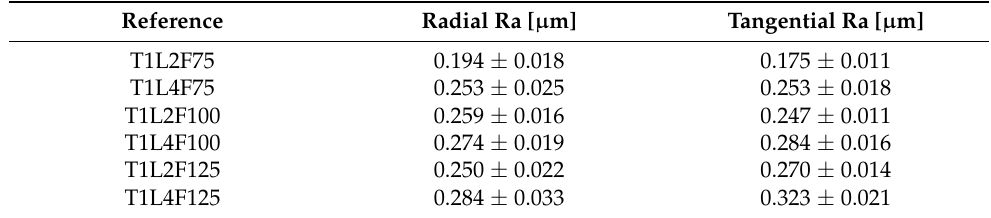
Table 5. Average surface roughness values, measured in the radial and tangential direction, for tests conducted using T1.